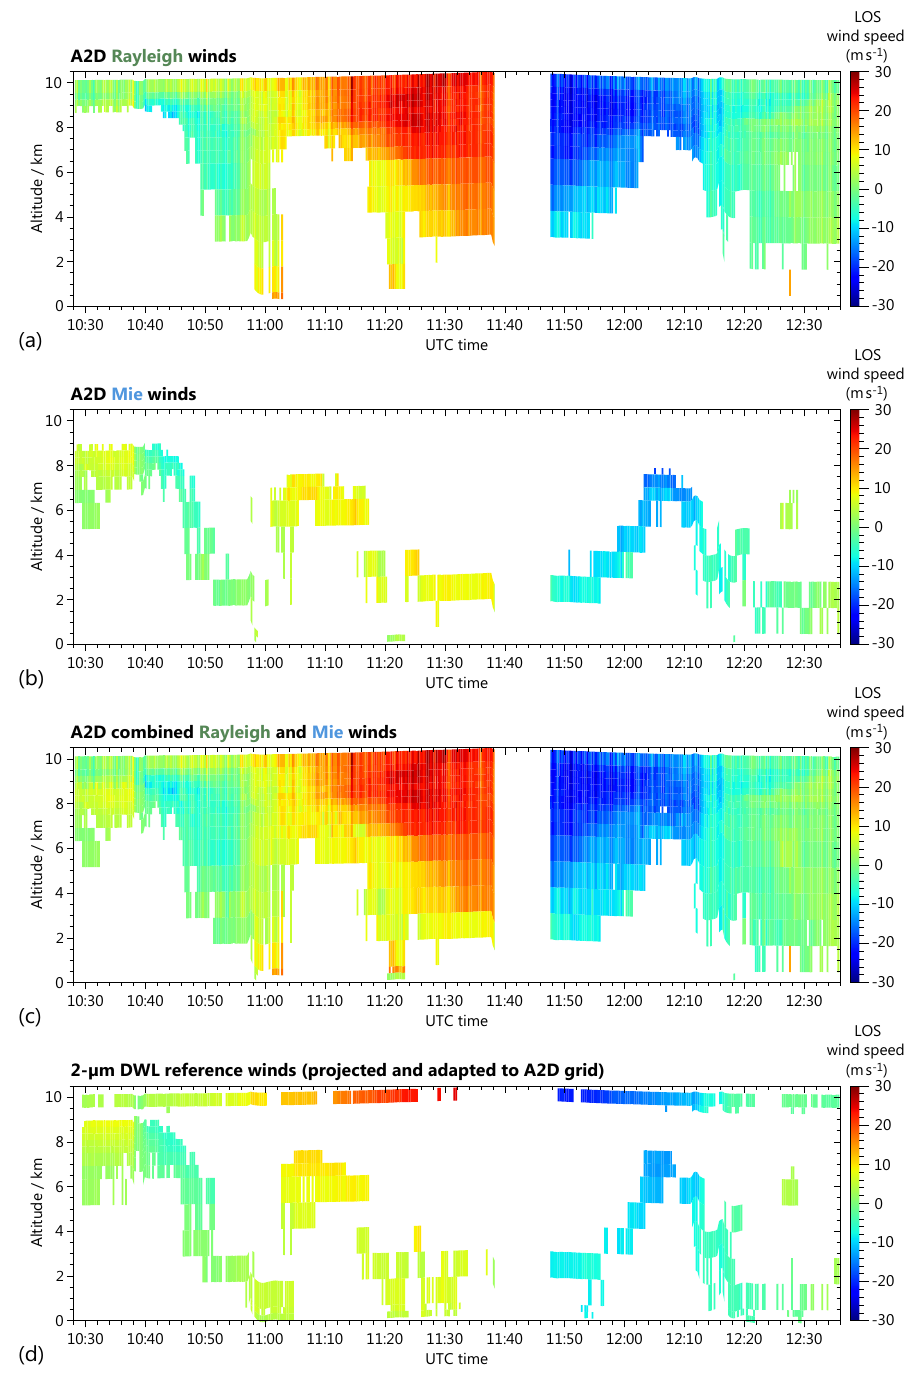
Figure 7. LOS wind profiles (positive towards the instrument) measured during the flight on 27 September 2016 between 10:28 and 12:36UTC using (a) the A2D Rayleigh channel and (b) the A2D Mie channel. The combination of both channels is depicted in panel (c) , while panel (d) shows the corresponding wind curtain obtained with the coherent 2µm reference wind lidar. For better comparison, the 2µm wind data were adapted to the measurement grid of the A2D. White colour represents missing or invalid data due to low signal, e.g. in case of low aerosol loads or below dense clouds. The data gap between 11:38 and 11:48UTC is due to an interruption of the wind measurement during a curve flight and a different operation mode of the A2D instrument aiming at the detection of the Rayleigh background signals on the Mie